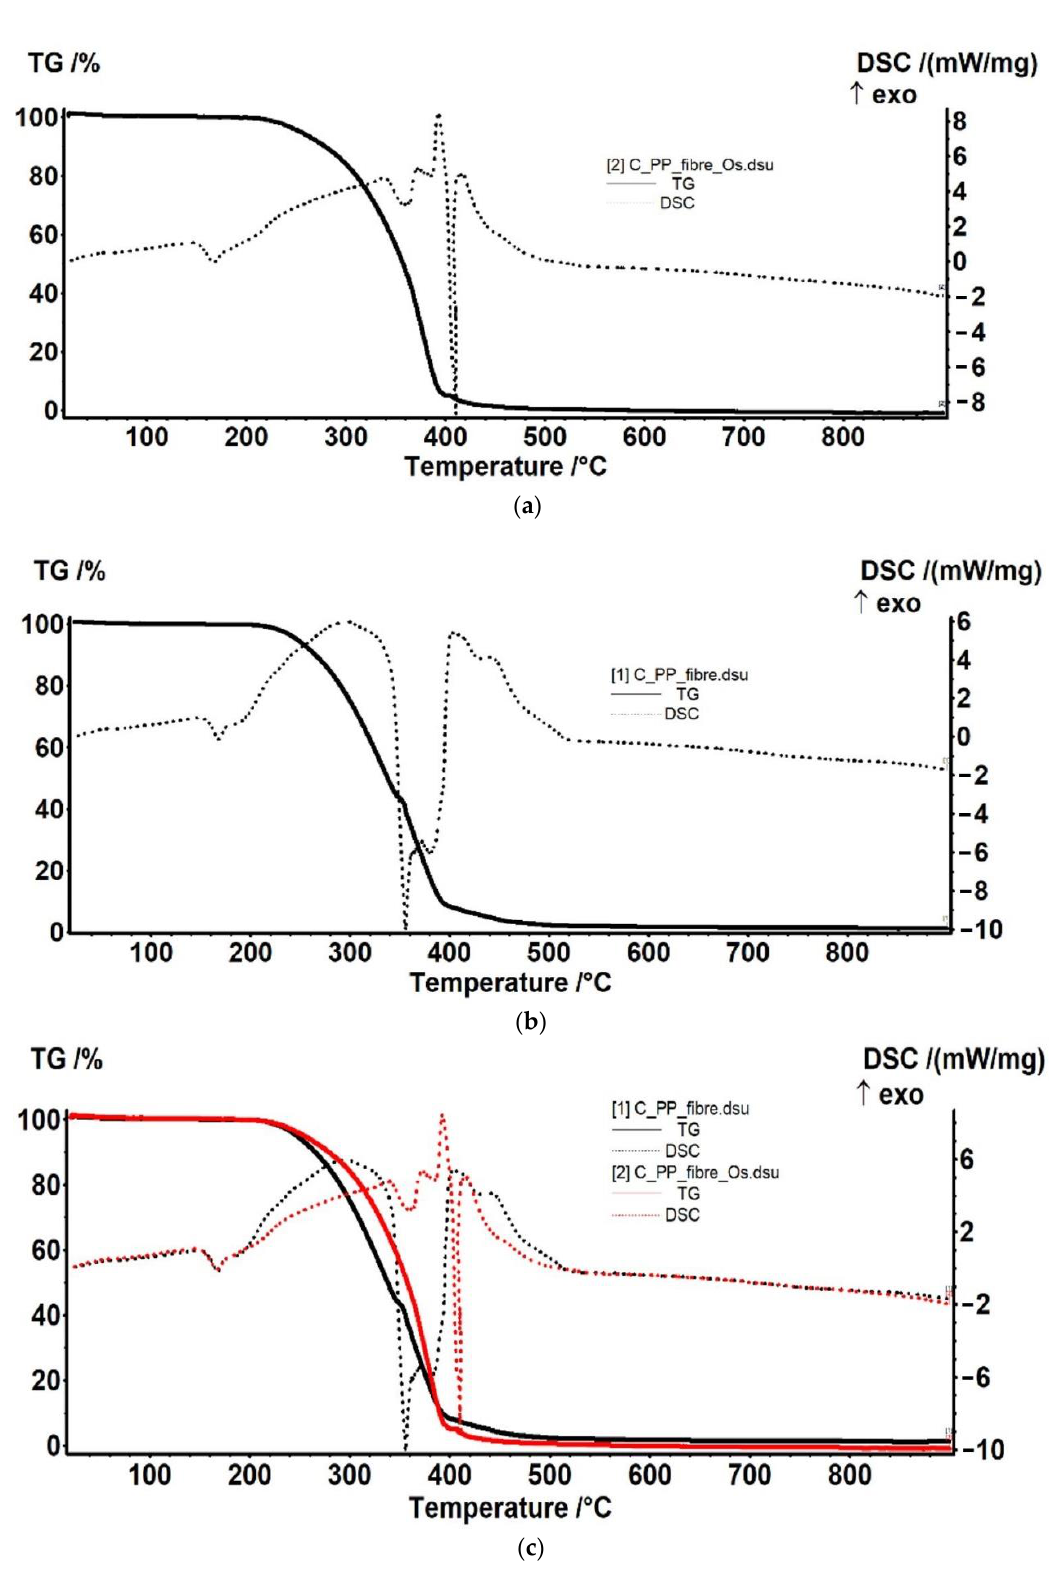
Figure 13. The thermal diagrams for: osmium–polypropylene membrane (Os–PP) ( a ); polypropylene hollow fiber membrane (PP) ( b ); and their overlap ( c ).